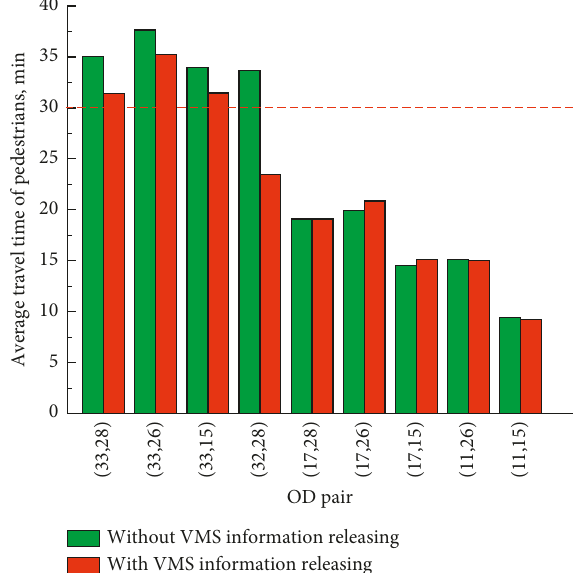
Figure 20: Distribution of travel time between each OD pair for the scenario of